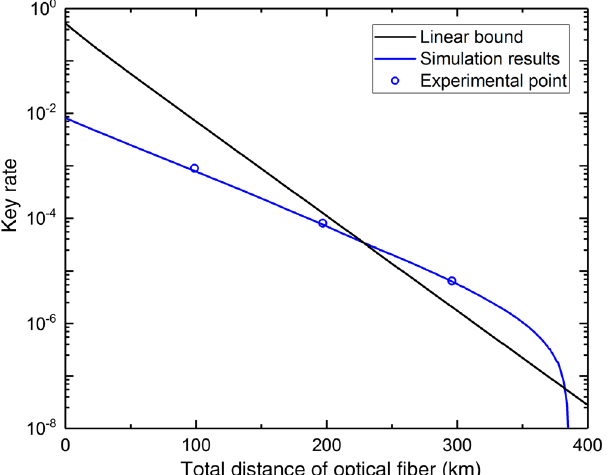
FIG. 5. Stability of the TF-QKD system over a total distance of 300 km. The blue open dots represent the interference visibility of Alice ’ s and Bob ’ s reference parts, and the red open dots are QBER of the corresponding quantum parts. Each dot corresponds to the data acquired in one visibility (blue open dots) and QBER (red open dots) in Fig. 5. Over 1000 seconds, the mean value of the inter-